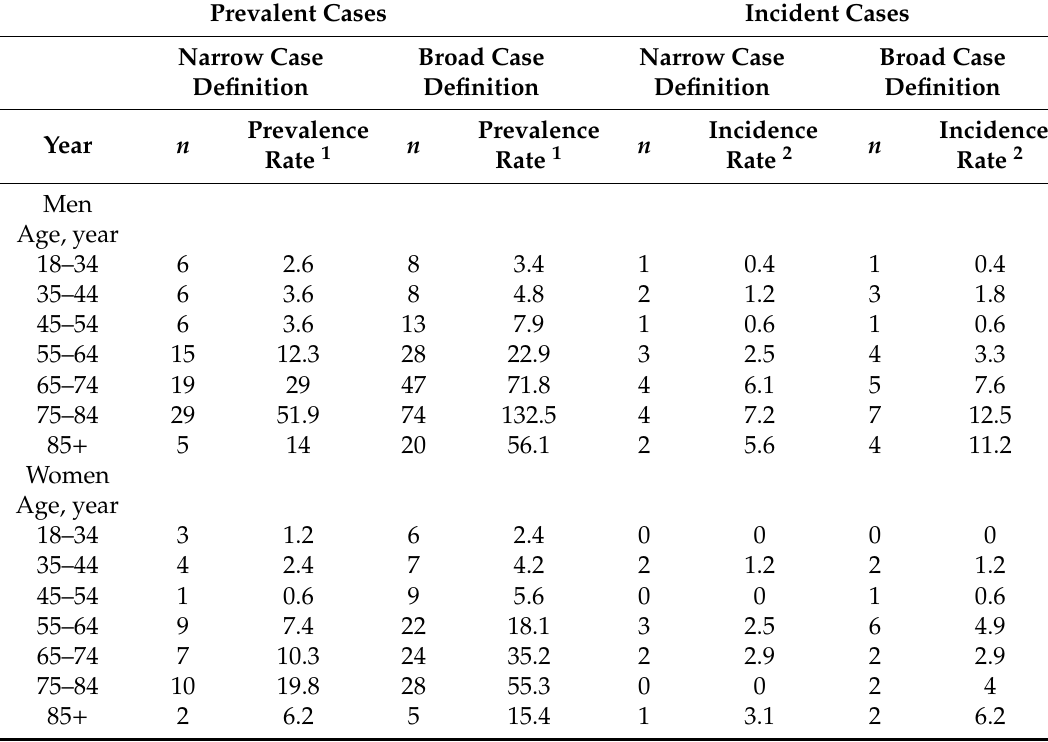
Table 2. Prevalent and incident cases of IPF in 2011 by age, sex, and case